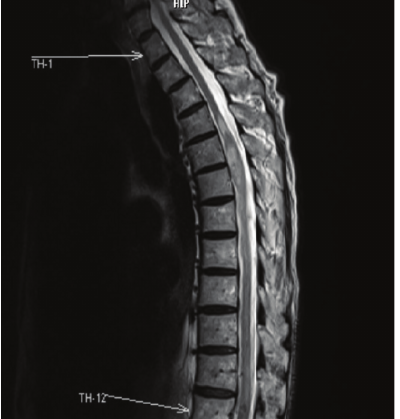
Figure1:Magneticresonanceimaging(MRI)revealedanintramed- ullary mass with signal intensity surrounded by a zone of high and low signal on T2 weighted images.